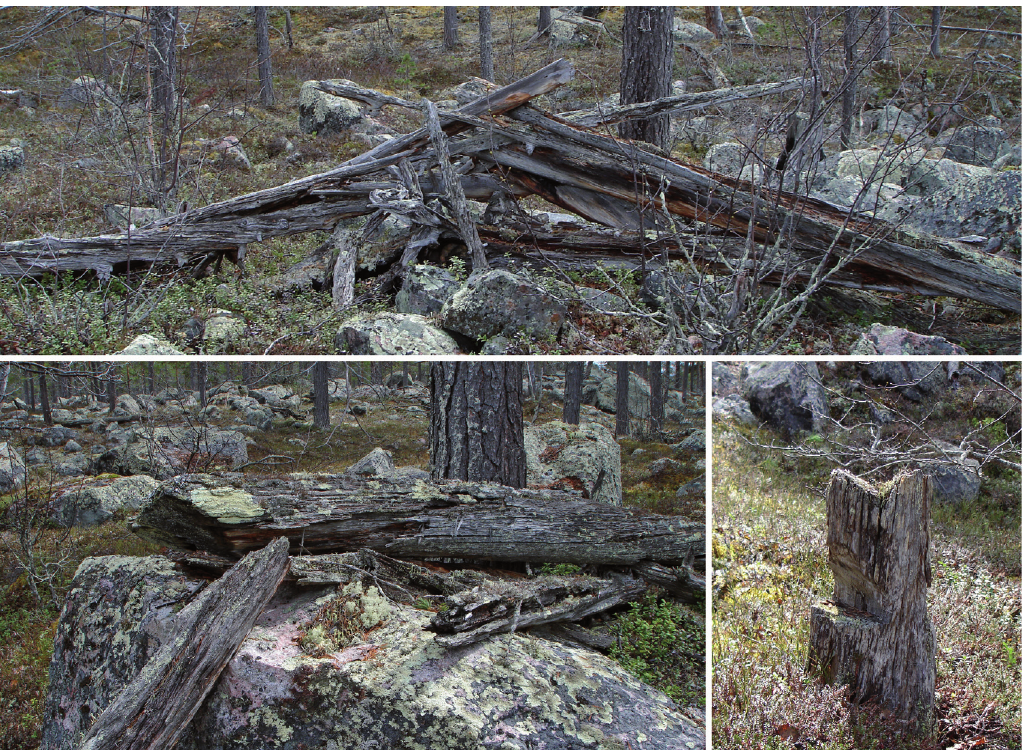
Figure 6. The three main types of joints. Upper photo, crosswise trunk type. Lower left, boulder type. Lower right, rooted stump